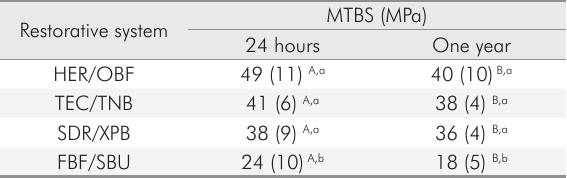
Table 2. Mean MTBS of different restorative systems applied to dentin.